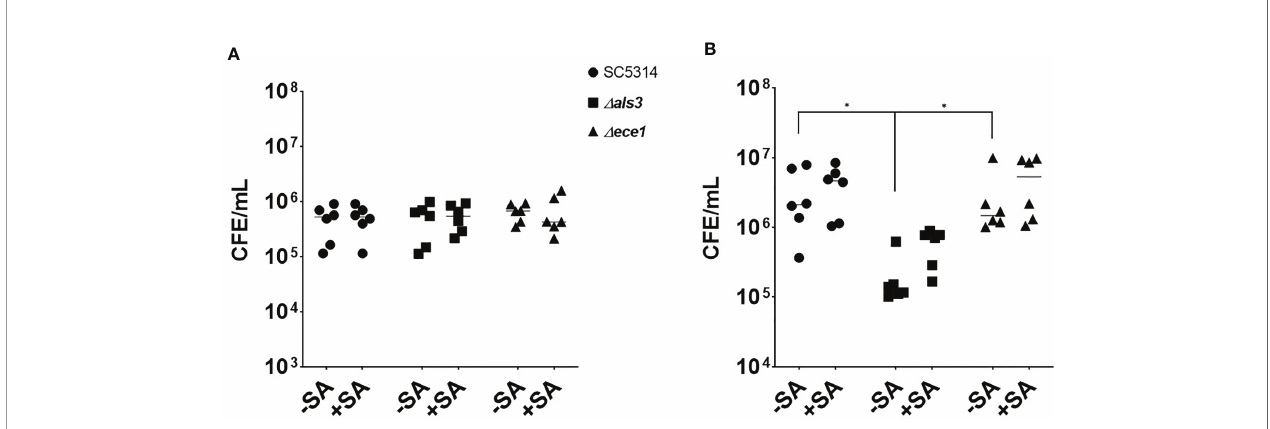
FIGURE 2 | Staphylococcus aureus does not in fl uence the total number of fungal cells in a dual-species bio fi lm. Bio fi lm biomass was removed via sonication, DNA was extracted and the total number of fungal cells in each bio fi lm was quanti fi ed using qPCR. The total number of C. albicans cells of (A) 4 h and (B) 24 h bio fi lms are presented as colony forming equivalents per mL (CFE/mL). Experiments were repeated three times on three separate occasions. Data points represent individual bio fi lms. CFEs of C. albicans SC5314 and ece1 D / D dual-species bio fi lms were compared to that of als3 D / D (*, P <